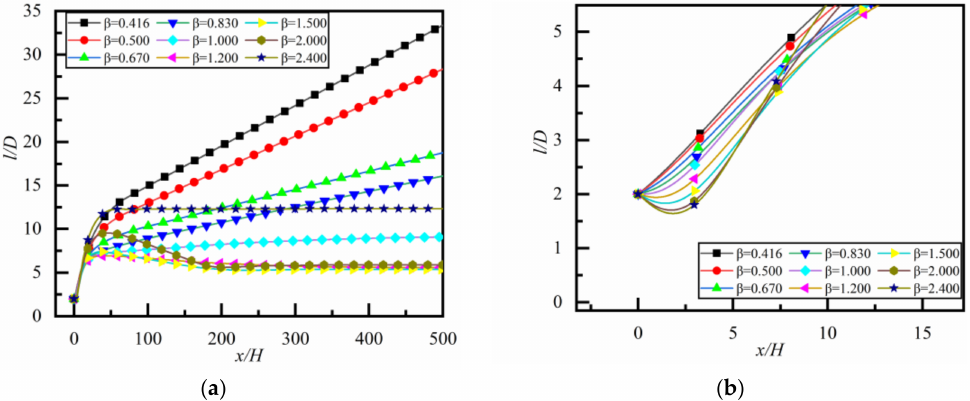
Figure 9. Effect of size ratio of particles on the distance between two particles (2000 × 150 ∆ x , Re = 20); ( a ) for a long distance along the flow direction; ( b ) at the initial